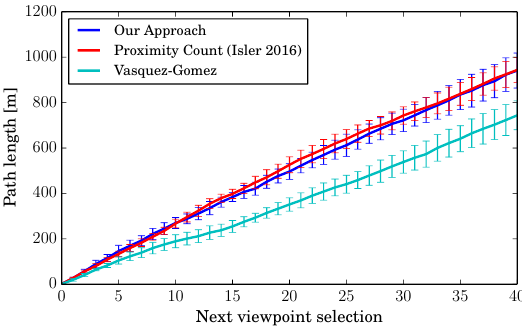
Figure 9. Trajectory length at each